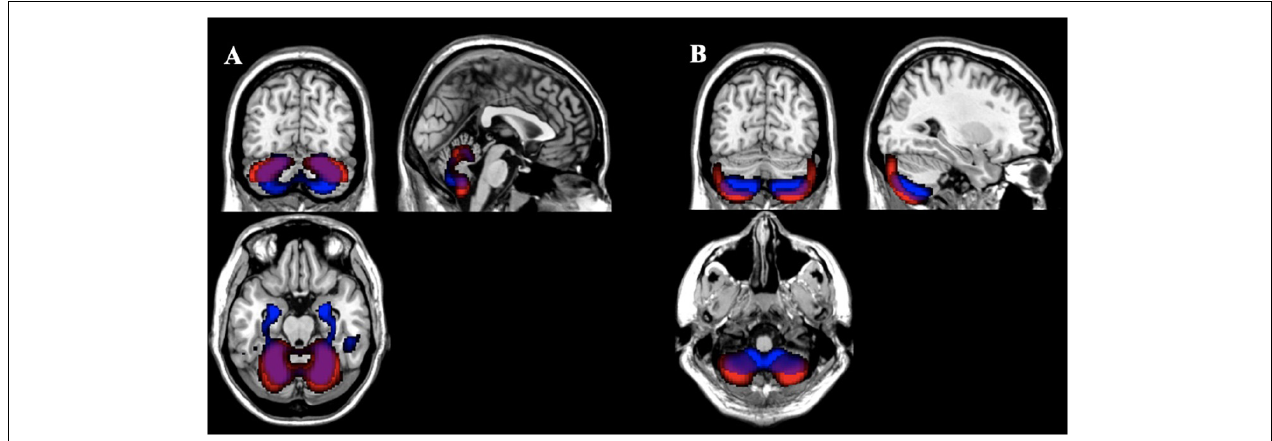
FIGURE 6 | Comparison of Gray Matter Concentration and Volume Spatial Patterns Gray matter concentration (red) and volume (blue) spatial patterns thresholded at z > | 2| with the largest Jaccard Index between them [ (A) 27.89%; (B) 25.73%] showing overlap primarily in the cerebellum for those voxels that passed threshold as a